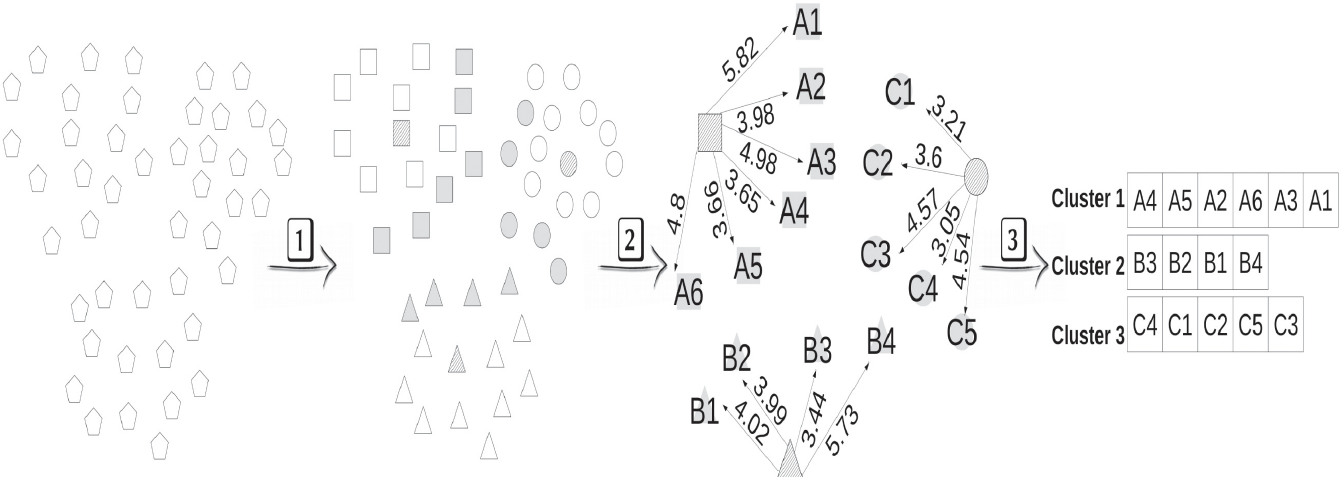
Fig 2. Stages of the RDBS active learning method consisting of the steps: 1) clustering, where root and boundary samples are identified, 2) distances between root and boundary samples from each cluster are calculated and 3) samples are organized into distinct lists in increasing order of distance. Pentagons represent samples before clustering, cracked samples represent root samples and gray samples represent boundary